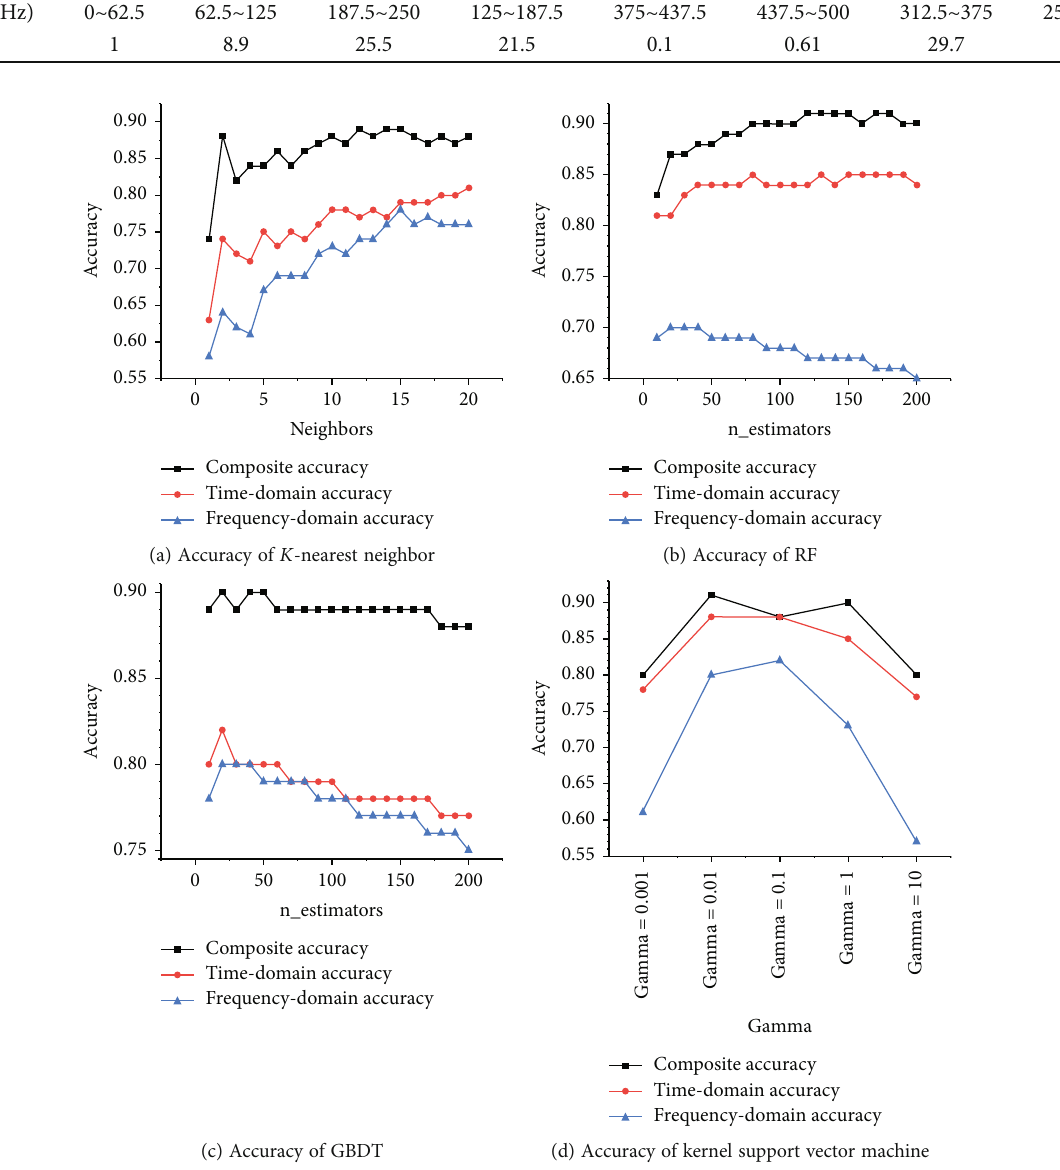
Figure 4: Accuracy of four machine learning